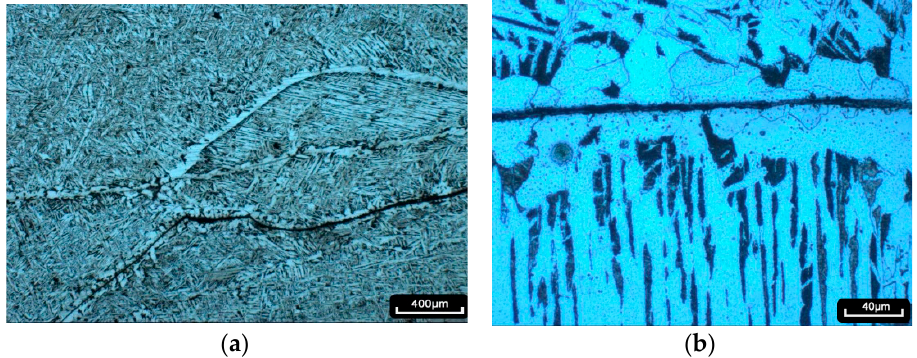
Figure 6. Microstructure of the crack. ( a ) Pro-eutectoid ferrite film generated along the grain boundary; ( b ) enlarged crack morphology.